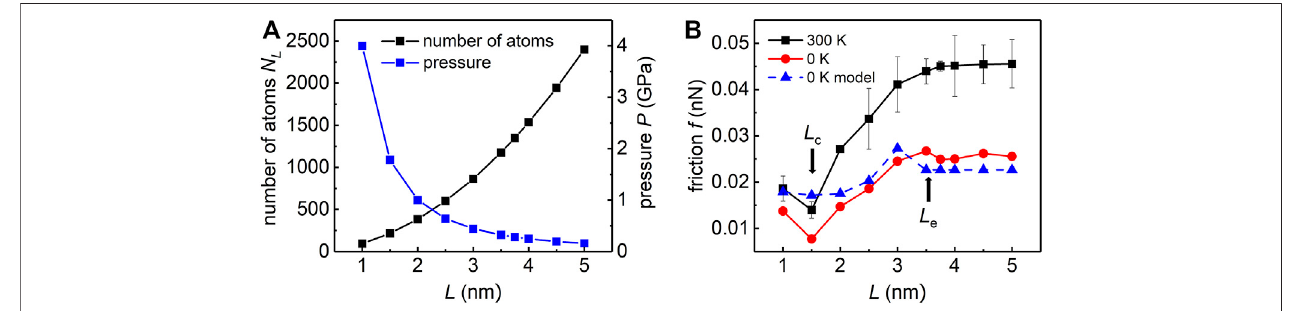
FIGURE 4 | Simulation for applying the same total force in the loading area. (A) Numbers of atoms in the loading area N L and pressure versus L . The product of N L and pressure remains constant. (B) Friction force of the fl ake along y direction versus L at 0 K (red) or 300 K (black). The result obtained by our model at 0 K is shown in